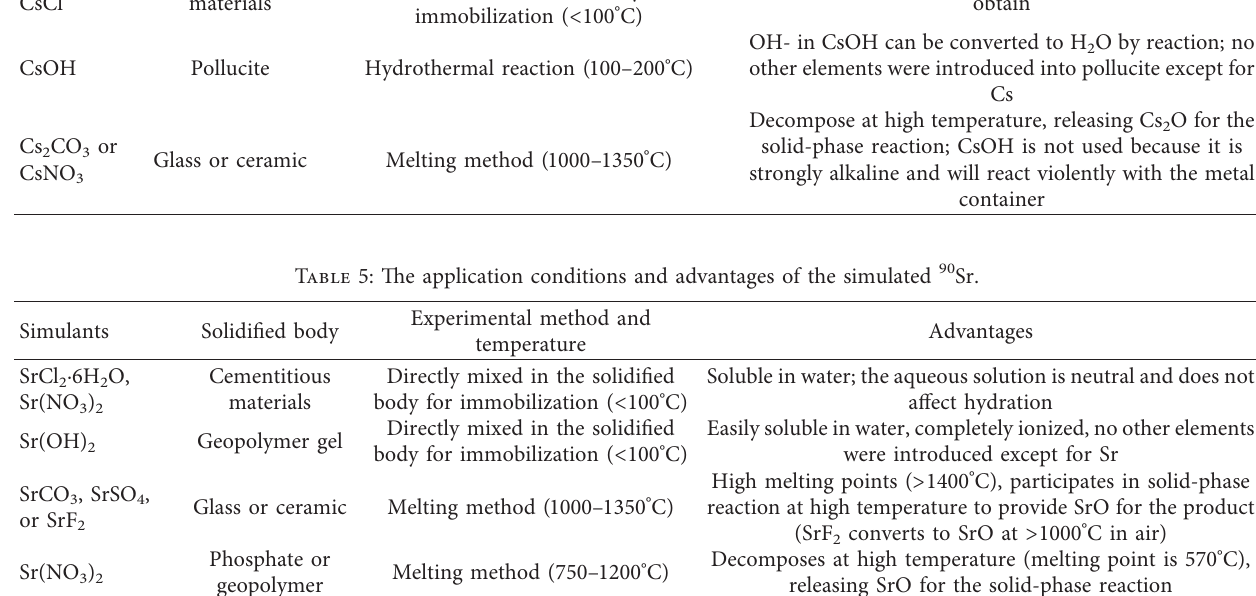
1.15 − x Cs 2 x Cr 2.3 Ti 5.7 O 16 .